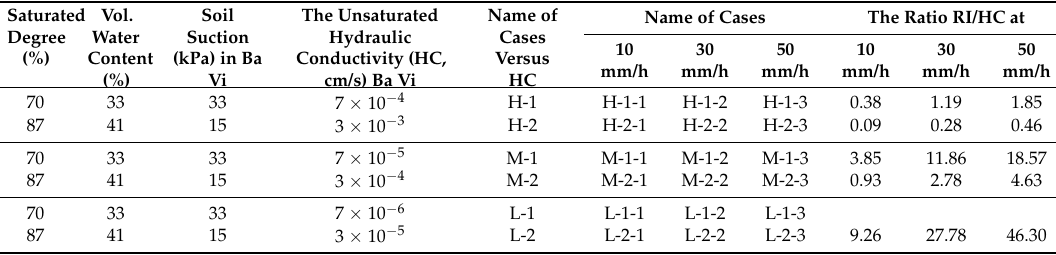
Table 2. Cases used to analyze Ba Vi riverbank.